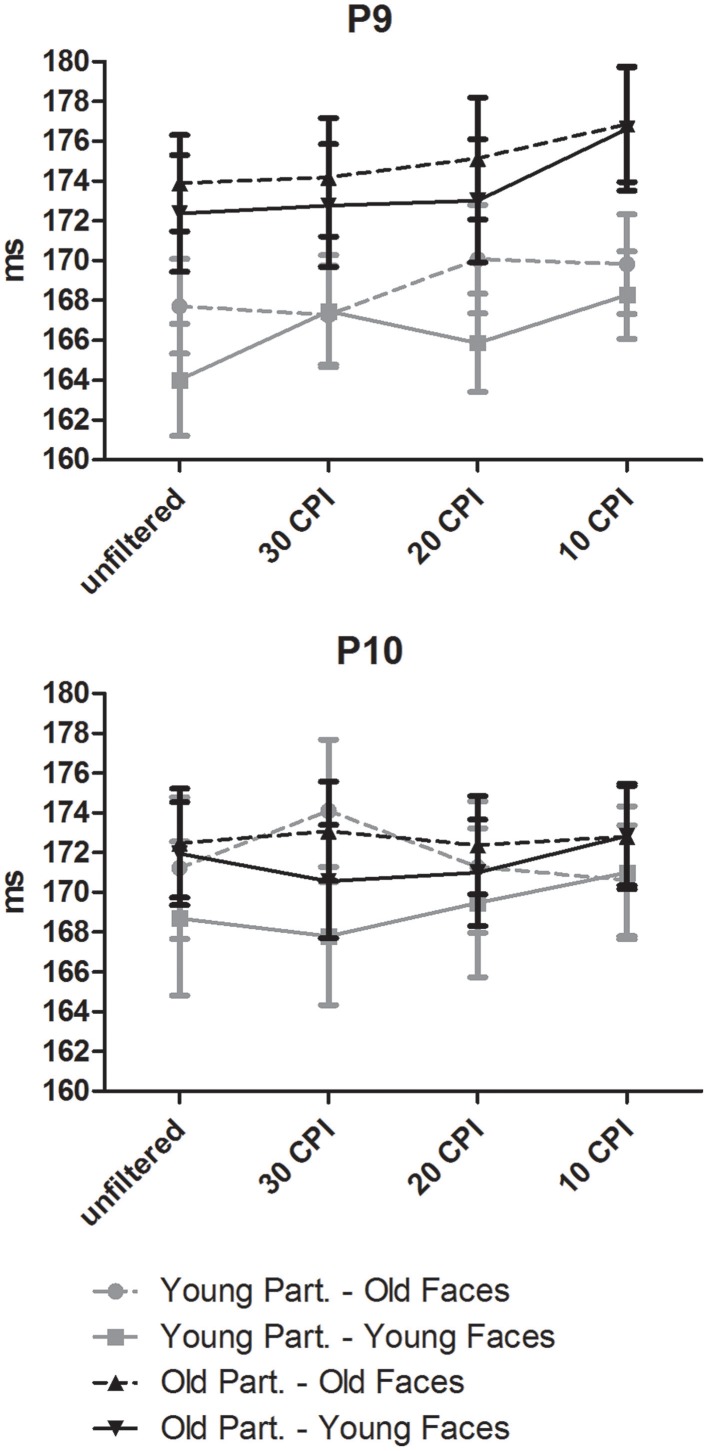
Effects of face age, low-pass filtering, and participant age on mean N170 latency. Error bars depict standard errors of the mean.